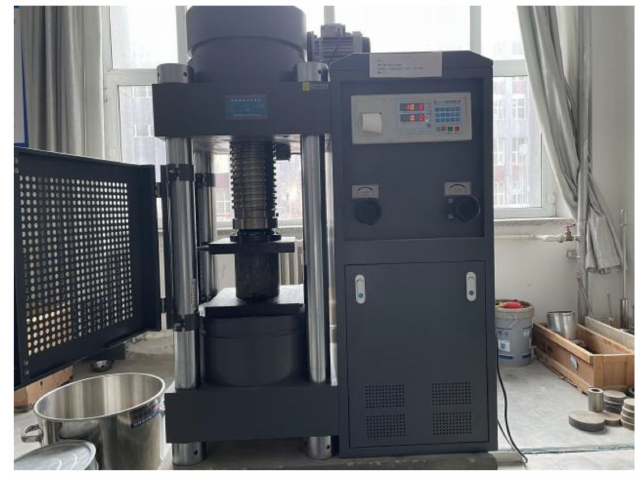
Figure 5. Fengyi RFP-03 Intelligent Dynamometer.